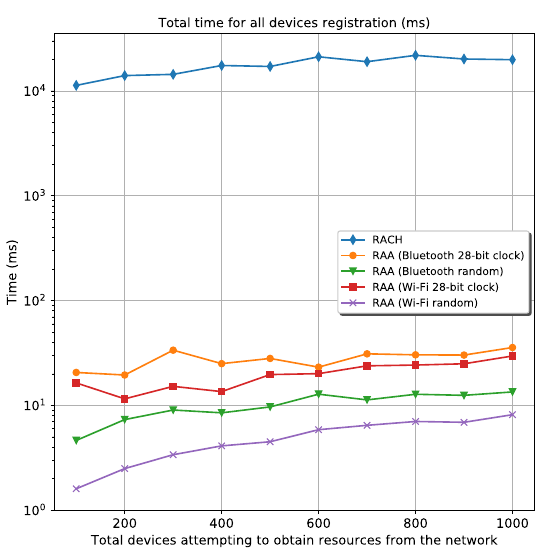
Figure 12. Elapsed time for all devices registration in all bands when there are 1000 connected devices to the mobile network before the new requesters start attempting to obtain resources from the network for the classic RACH and four di ff erent RAA